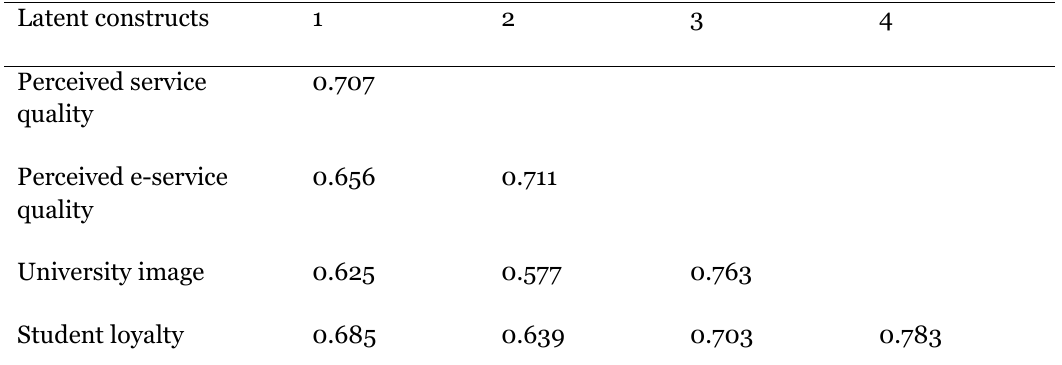
Results of Discriminant Validity